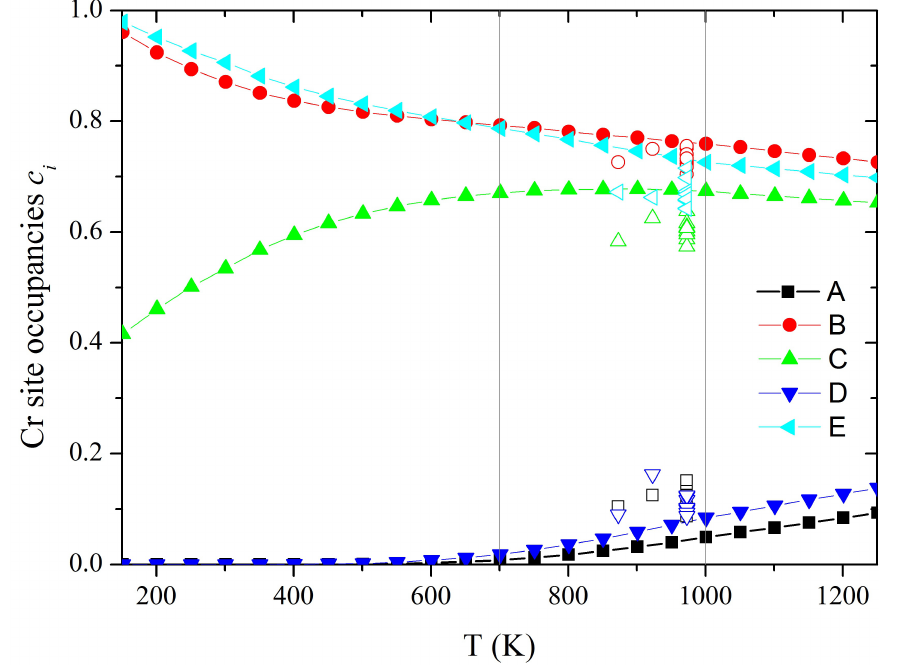
Figure 2. The Cr site occupancies of the (A, B, C, D, E) sublattices versus temperature including the magnetic and temperature effects in the Fe denote the available experimental data (error bars within the symbol sizes) [2,28]. The vertical lines indicate the temperature range of the σ -phase formation in the Fe-Cr alloy. (Reprinted figure with permission from [16] as follows: Kabliman, E.; Blaha, P.;